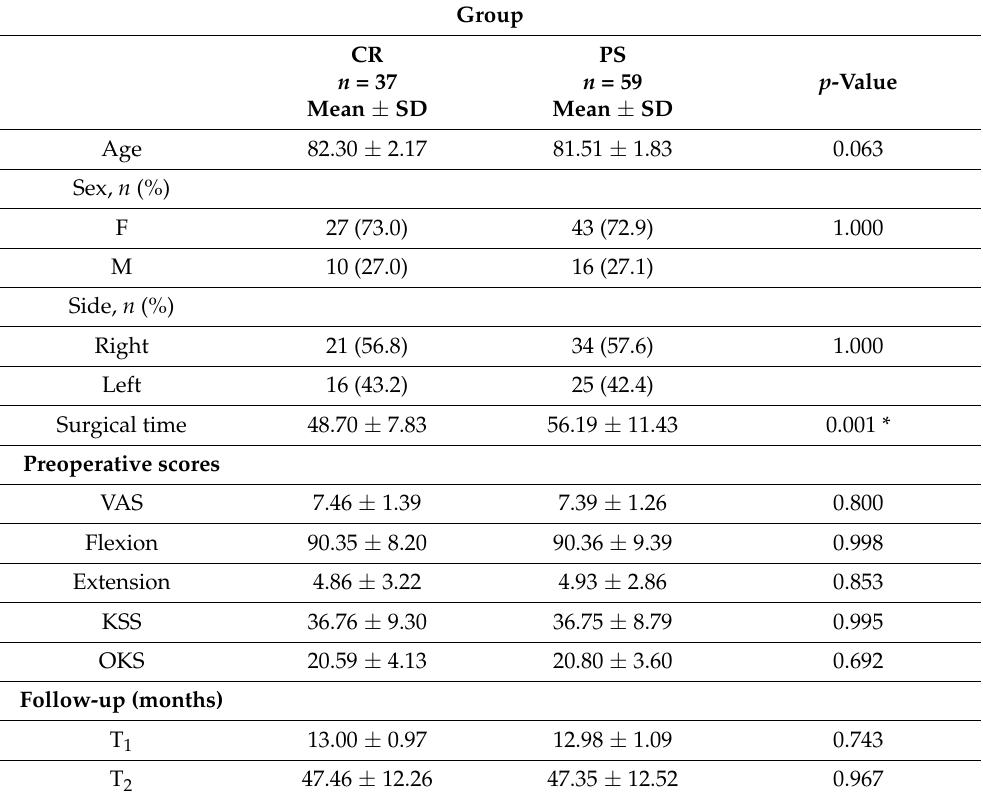
Table 1. Pre- and intraoperative comparisons between